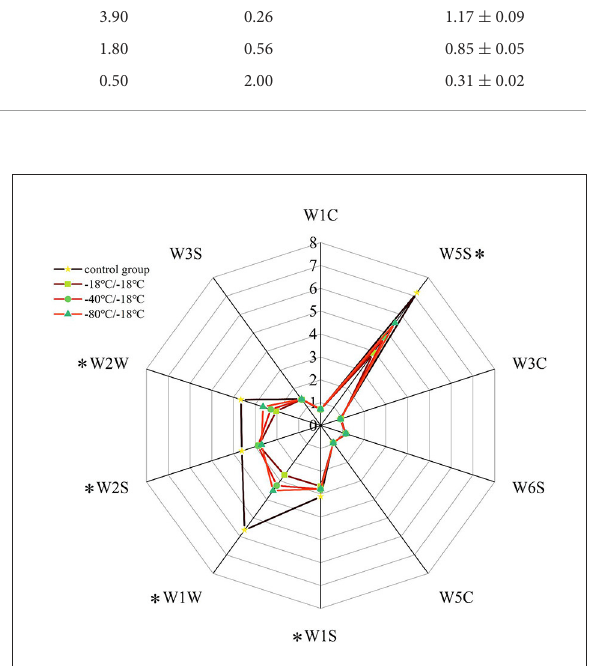
FIGURE3 E-nose radar image of volatile flavor compounds. * Represents significant differences ( P <